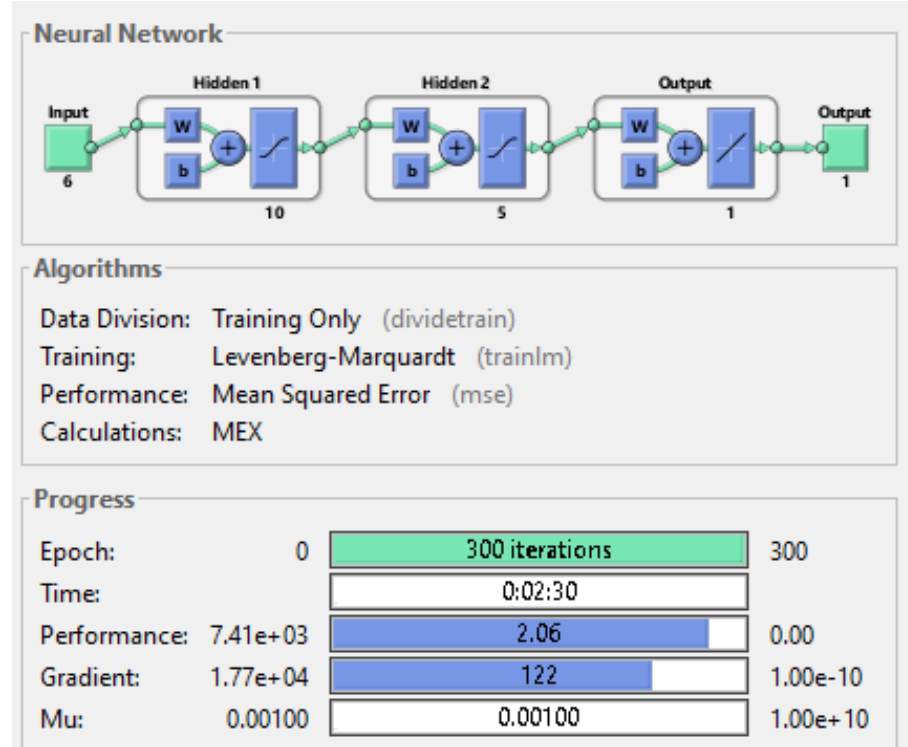
Figure 5. Simulink diagram ANN-based speed estimator.